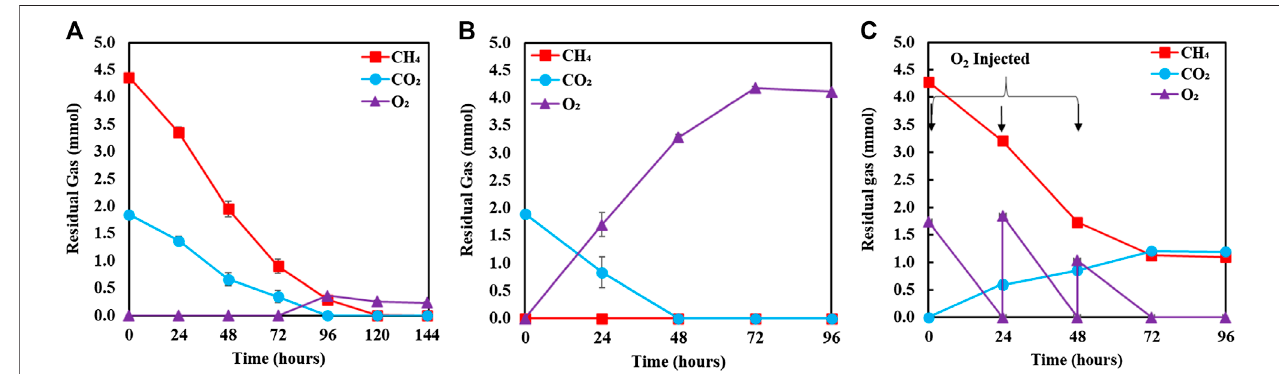
FIGURE 9 | Gas phase composition over time for (A) coculture, (B) sequential single culture microalga, and (C) sequential single culture methanotroph.